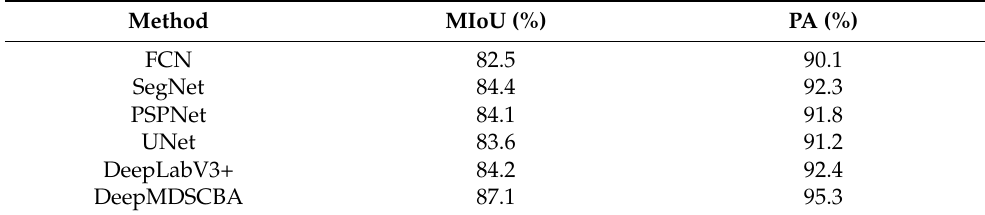
Table 6. Performance of different apple image segmentation methods.